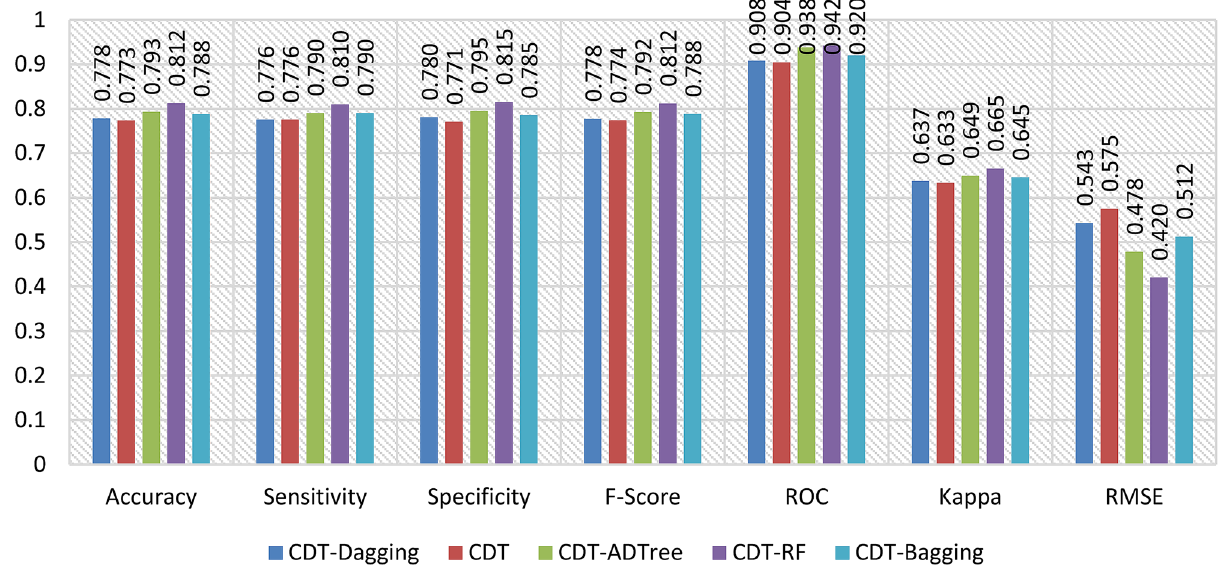
Figure 2. Training performance of the models.